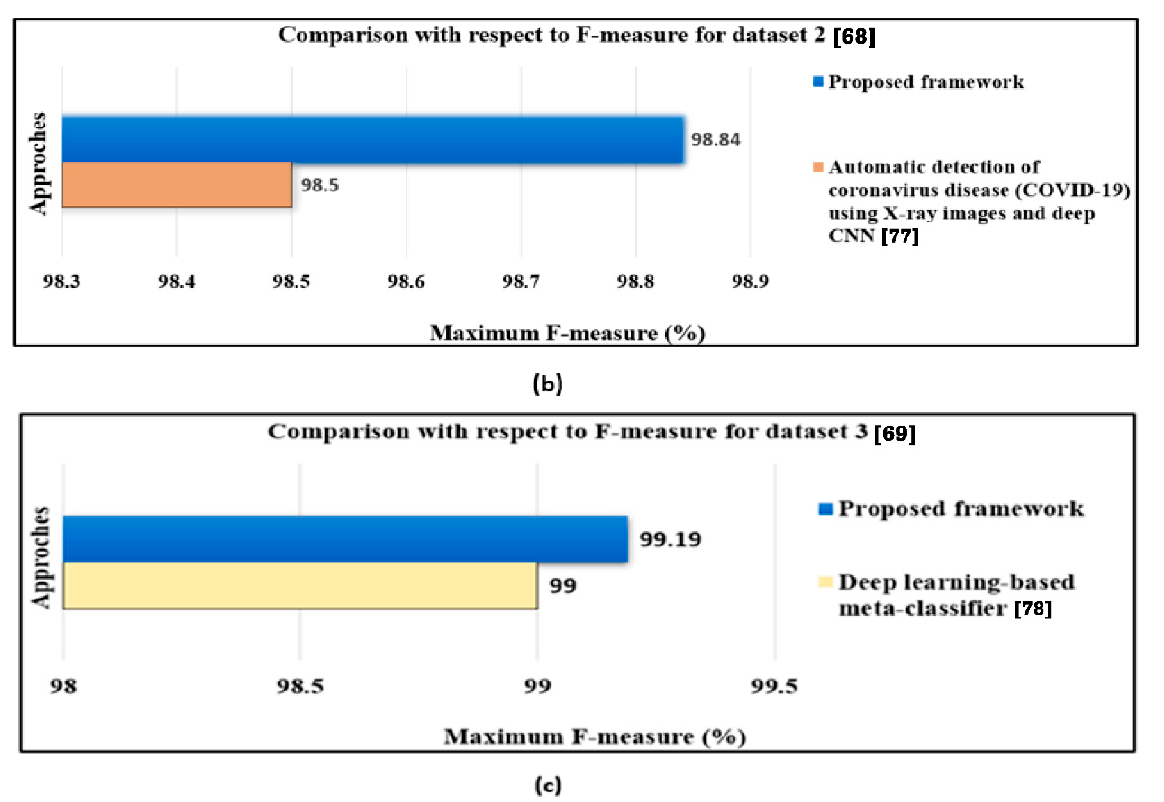
Figure 11. Comparison among some existing techniques [20,50,73–78] and our proposed framework with respect to F-measure for ( a ) dataset 1 [66], ( b ) dataset 2 [68], and ( c ) dataset 3